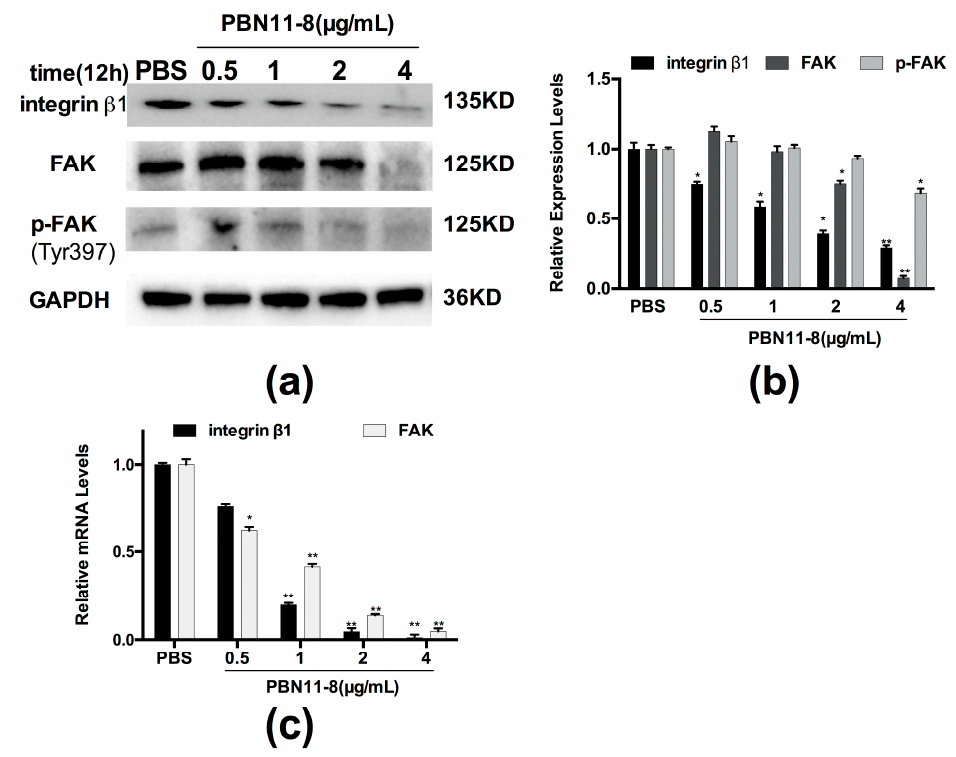
Figure 5. PBN11-8 inhibits the activation of FAK in BEL-7402 cells. ( a ) BEL-7402 cells were treated with (and without) 0.5, 1, 2, and 4.0 µg/mL PBN11-8. After incubation for 12 h, cells were collected and the cell protein was isolated for Western blot analysis of integrin β 1, focal adhesion kinase (FAK), and p-FAK. Cells treated with PBS were used as negative control and the expression of GAPDH was used as an internal reference. ( b ) The quantitative evaluation of each lane of BEL-7402 cells in the Western blot was measured by Image J (National Institutes of Health, Bethesda, MD, USA) and normalized to untreated cells. ( c ) BEL-7402 cells were treated with (and without) 0.5, 1, 2, and 4.0 µg/mL PBN11-8. After incubation for 12 h, cells were collected and the total RNA was isolated. qRT-PCR analysis of integrin β 1 and FAK was performed as described in Materials and Methods section. Cells treated with PBS were used as negative control and the expression of GAPDH was used as an internal reference. Data represent the mean ± SD of three independent experiments. * p < 0.05 vs. control; and ** p < 0.01 vs. control.